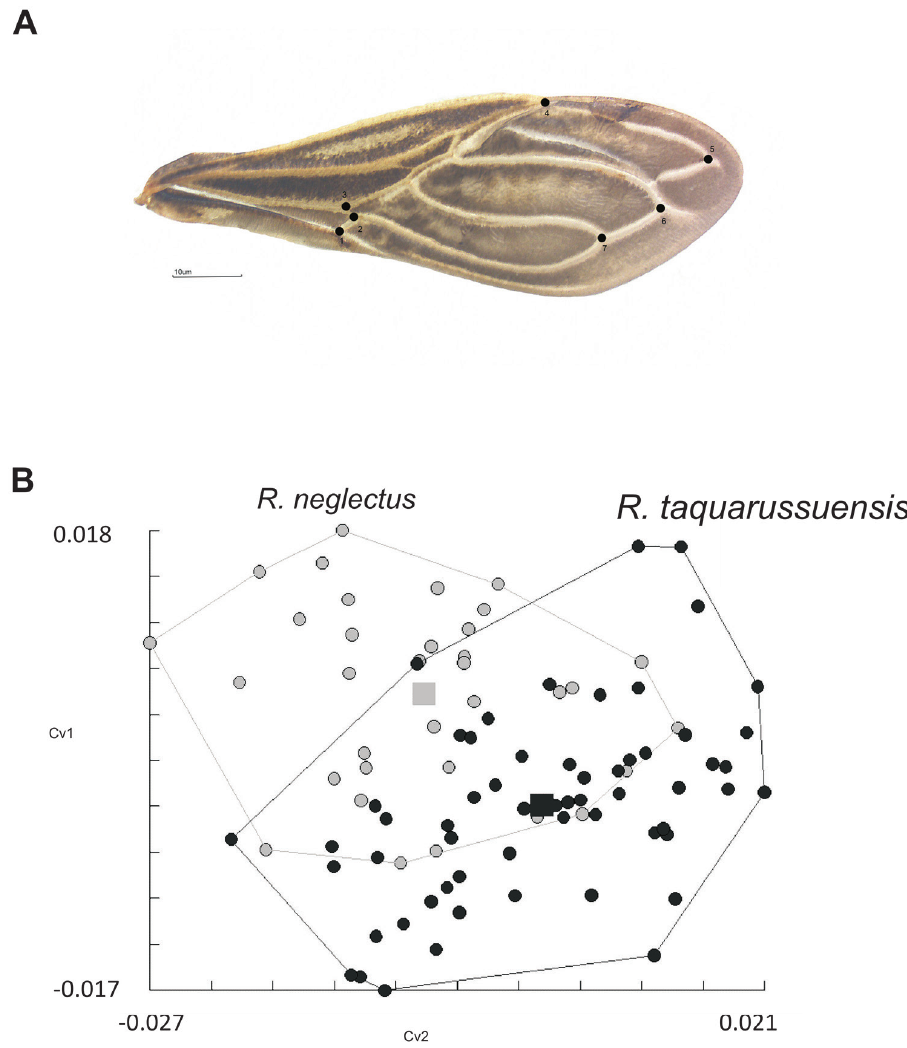
Figure 10. A Right wing of R. taquarussuensis sp. n. with the seven landmarks used in morphometric analysis. Following Bookstein (1990), all points correspond to type I landmarks (venation intersections) B Factorial maps in the plane of the two discriminant factors of wing shape variation (canonical variables 1 and 2, or CV1 and CV2) presenting the distribution of specimens of R. taquarussuensis sp. n. (Rta, black cicle) and R. neglectus (Rne, silver